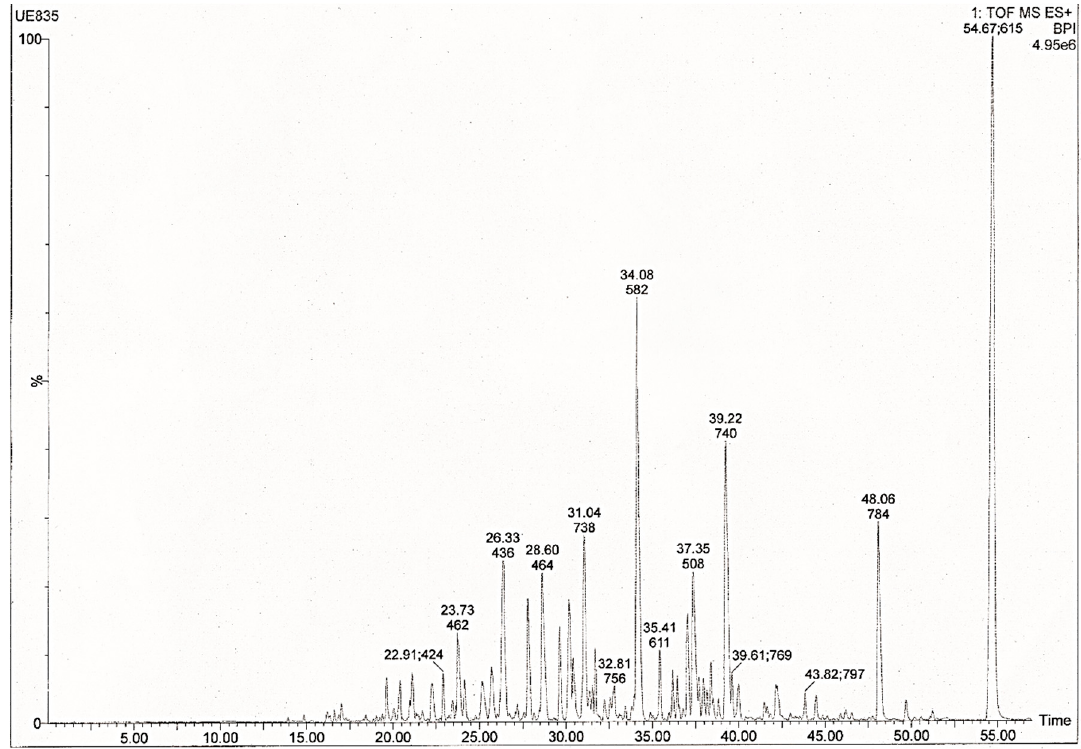
Figure 5. UPLC-TOF mass spectra obtained in a positive ion of tryptic peptides extracted from 55–70 kDa band separated by SDS-PAGE of ASA-treated parasites.